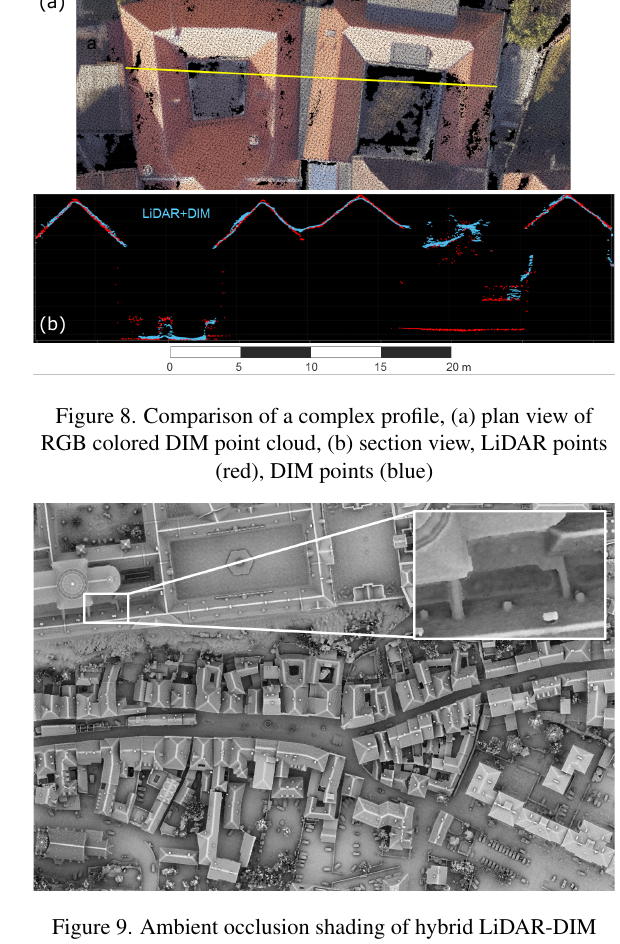
Figure 9. Ambient occlusion shading of hybrid LiDAR-DIM DSM mesh; detail: narrow alley within the abbey with roof points stemming from DIM and ground floor points from